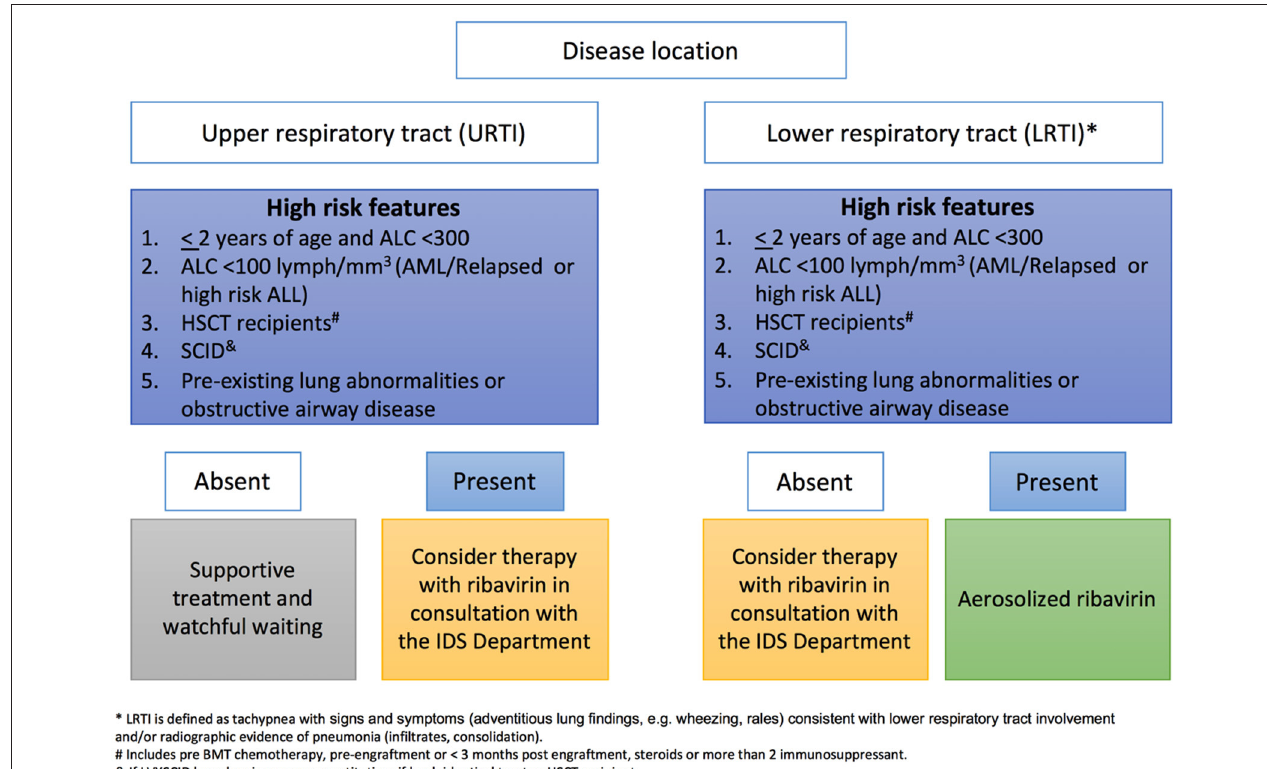
FIGURE 1 | Institutional decision tree used at St Jude for inhaled Ribavirin therapy based on risk factors of patients infected with